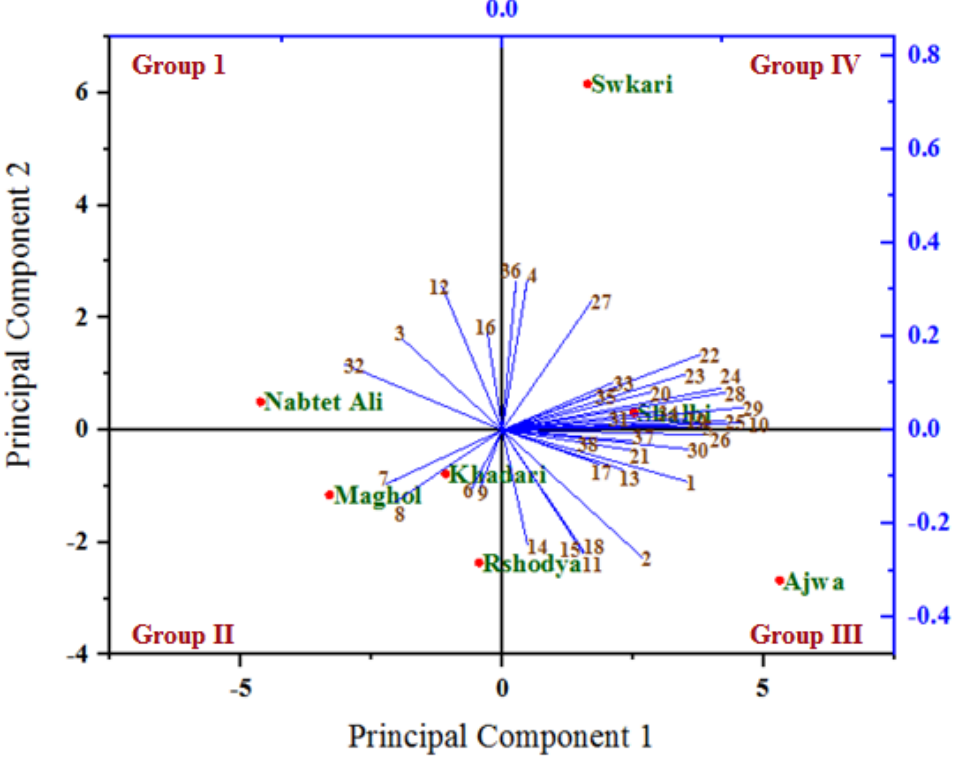
Figure Figure 6. A biplot diagram based on PC1 and PC2 shows similarities and dissimilarities in rela ‐ tionships among the measured variables across different varieties of palm dates under untreated.